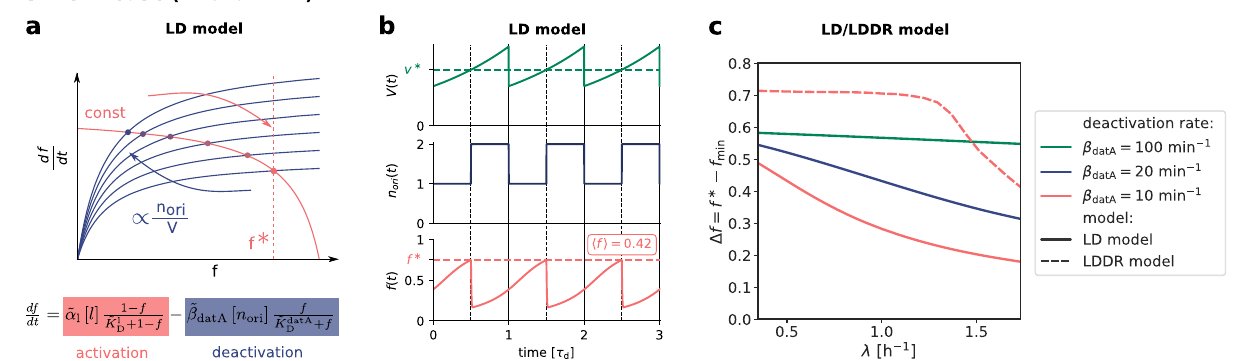
Fig.3|Anultra-sensitiveswitchbetweenATP-DnaAandADP-DnaAgivesriseto stable cell cycles. a LD model: The constant activation rate (red curve) and the origin density-dependent deactivation rate (blue curve) as a function of the active fractionoftheinitiatorprotein f atdifferentmomentsof the cellcycle.The steady- stateactivefractionsaregivenbytheintersectionoftheactivationanddeactivation rates (colored dots) and when f equals the critical initiator fraction f * , replication is initiated. A doubling of the number of origins leads to a decrease of the active fraction f . b LDmodel:Thevolumeofthecell V ( t ),thenumberoforigins n ori ( t )and the fraction of ATP-DnaA f ( t ) from Eq. (3) as a function of time (in units of the